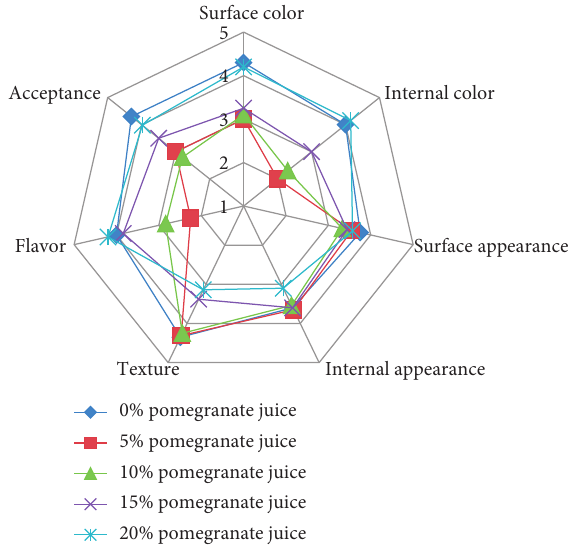
Figure 2: Sensory properties of Fruit whey-less Feta-type